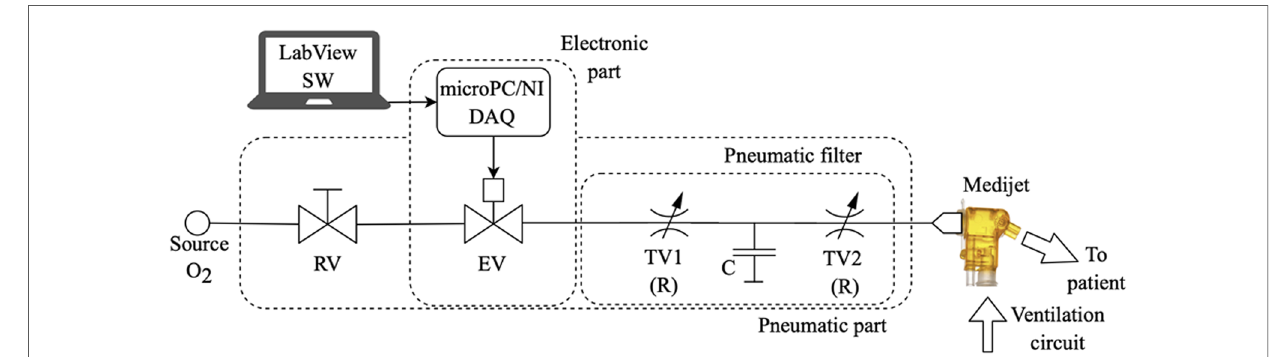
FIGURE 2 The schematic arrangement of the O 2 -FS in con fi guration with the Medijet CPAP interface. The same principle applies in the case of the Infant Flow or Infant Flow Low Pressure interfaces. Symbols: RV, reducing valve; EV, electromagnetic controlled valve; TV1 and TV2, throttle valves; C, pneumatic